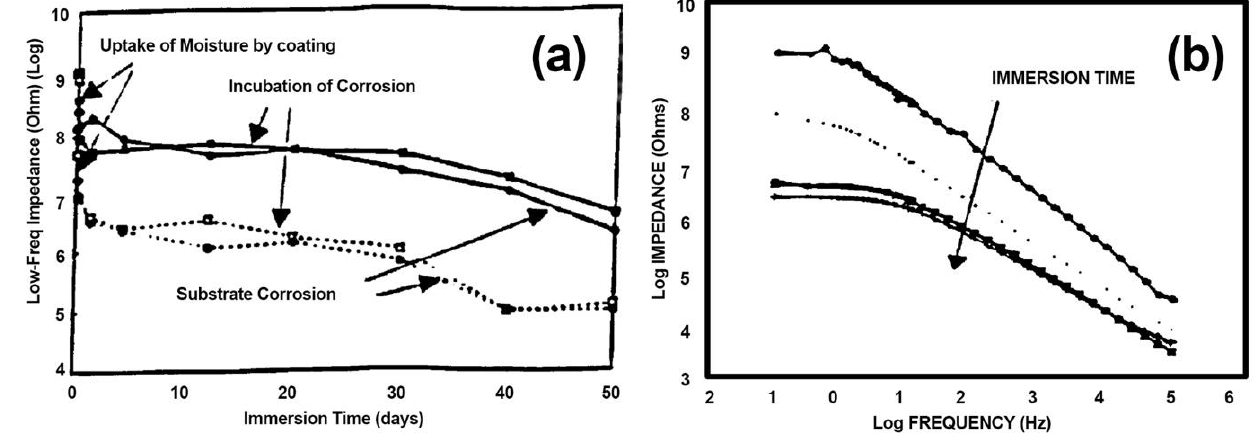
Figure 4. ( a ) The evolution of low-frequency impedance with exposure time of coated metal samples. ( b ) The impedance becomes independent from the frequency as the coating deteriorates [76].